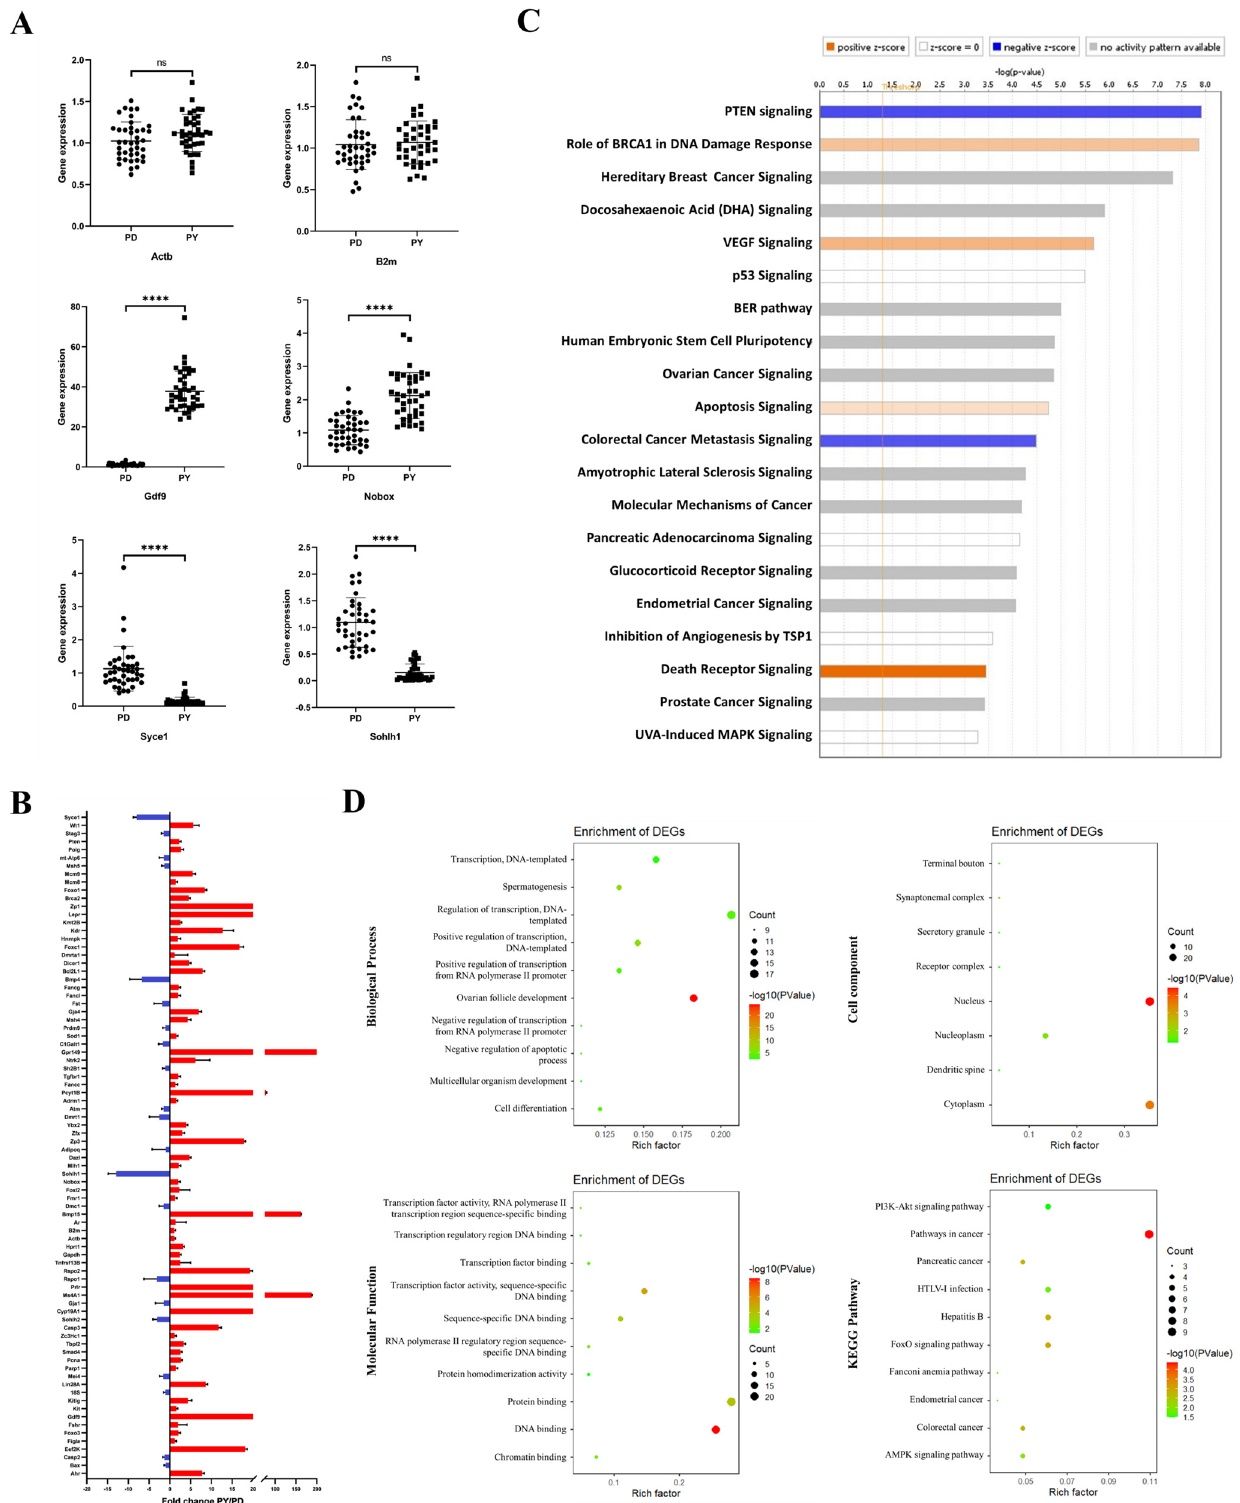
Figure 1. Gene expression in single oocytes. ( A ) The expression of single genes in the 80 oocytes. PD represents the primordial follicle oocytes, and PY represents the primary follicle oocytes. The Y-axis represents fold-changes using 2 − △△ Ct , and **** represents p < 0.0001. ( B ) The expression of the 82 candidate genes in primary follicles compared with primordial follicles. ( C ) Top 20 canonical pathways predicted by IPA core analysis. The orange columns represent pathways that may promote follicle activation, while blue represents pathways that may inhibit follicle activation. ( D ) GO and KEGG analyses of DEGs.